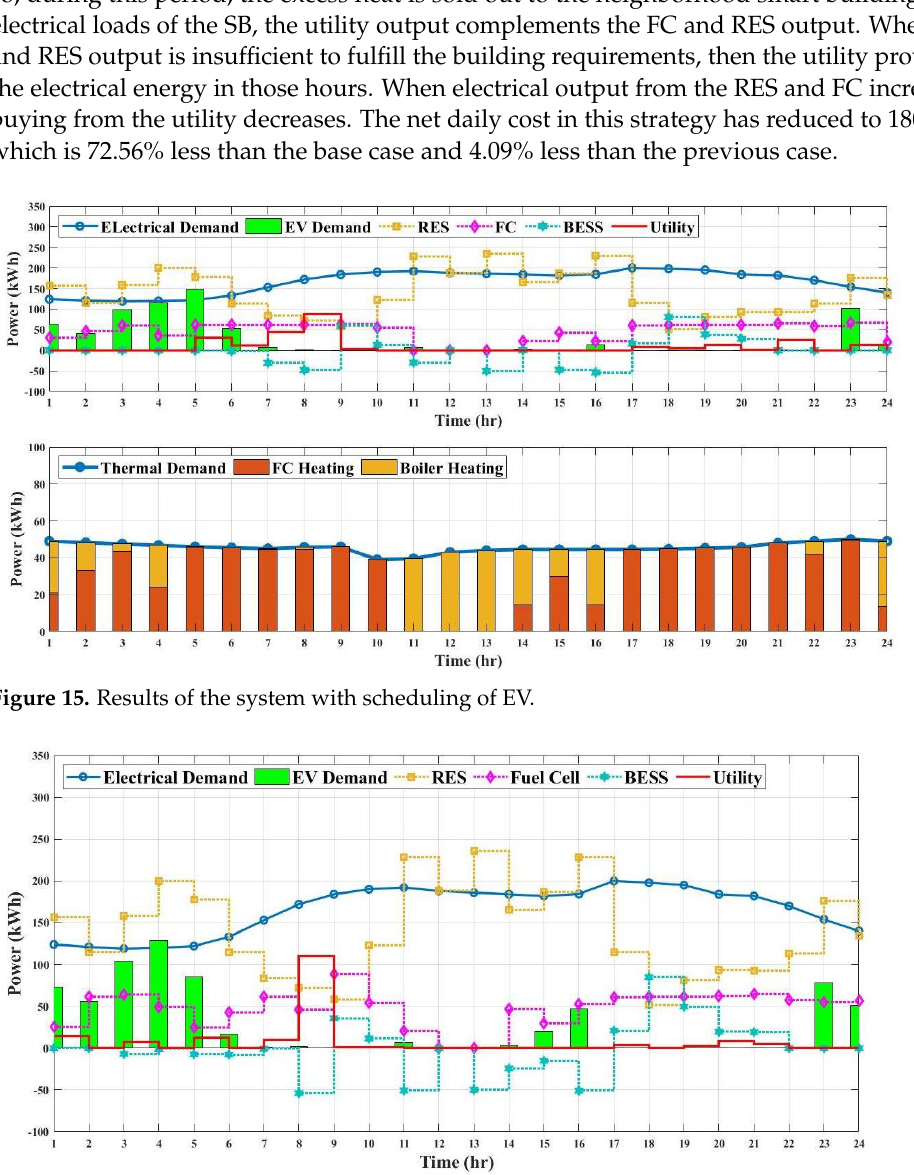
Figure 16. Electrical powers for Case